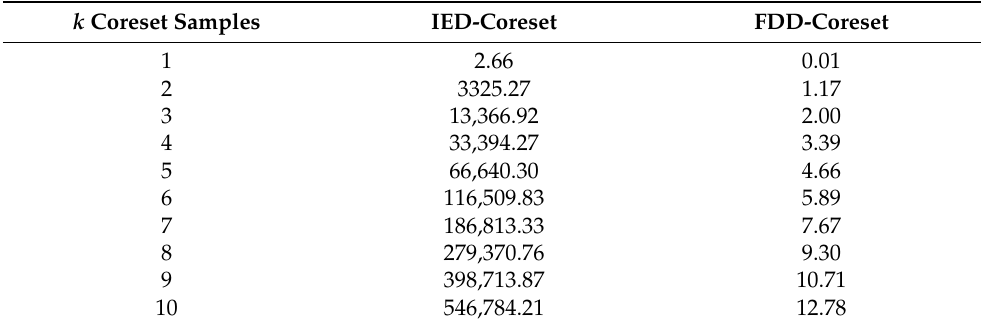
Table 1. Computation time comparison of IED-Coreset and FDD-Coreset on 3D synthetic blob images (unit: seconds).